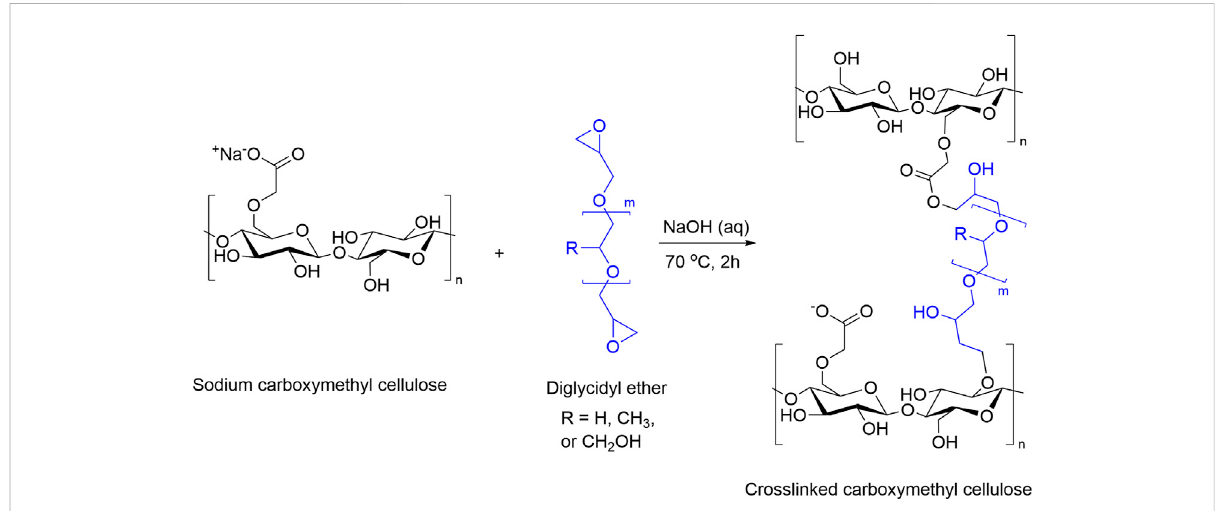
FIGURE 4 Proposed reaction scheme for the crosslinking of carboxymethyl cellulose with PEGDE (R = H), PPGDE (R = CH 3 ), and GDE (R = CH 2